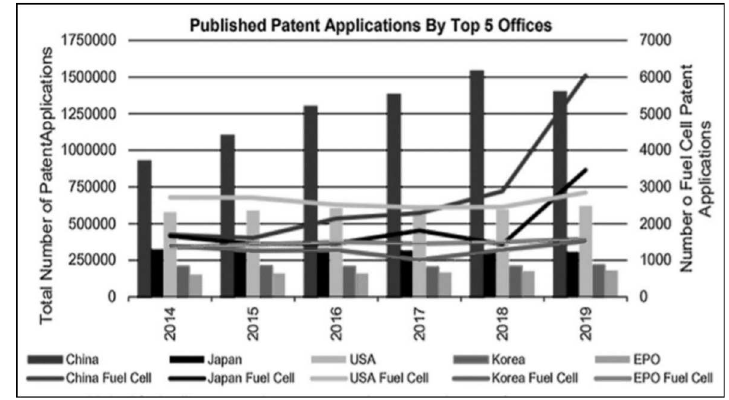
Published fuel cell patent applications vs total patent applications in years 2014–2019 at Top 5 Patent